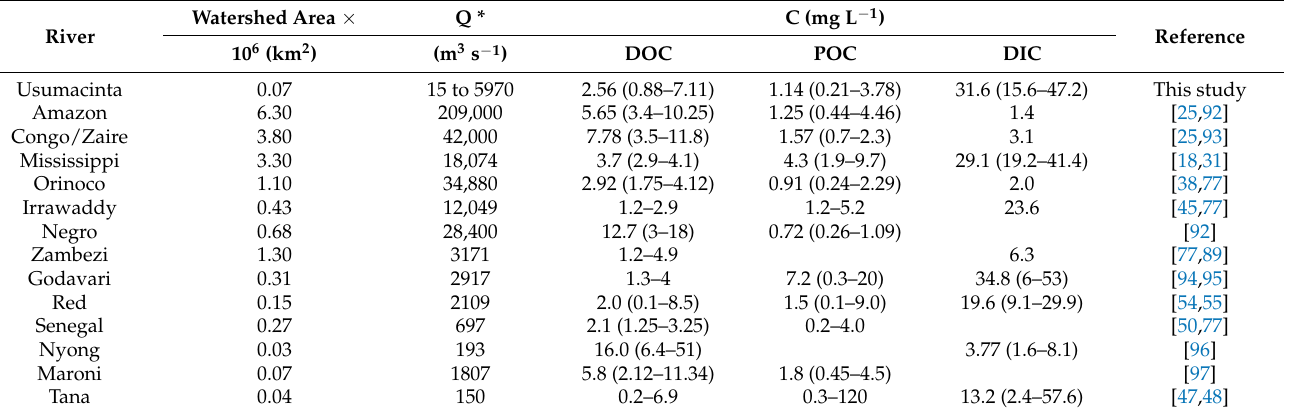
Table 3. C concentrations in tropical rivers around the world. The temperate Mississippi River, which also discharges into the Gulf of Mexico, was included for comparative purposes. (* Data from [91]. The average and range are shown).